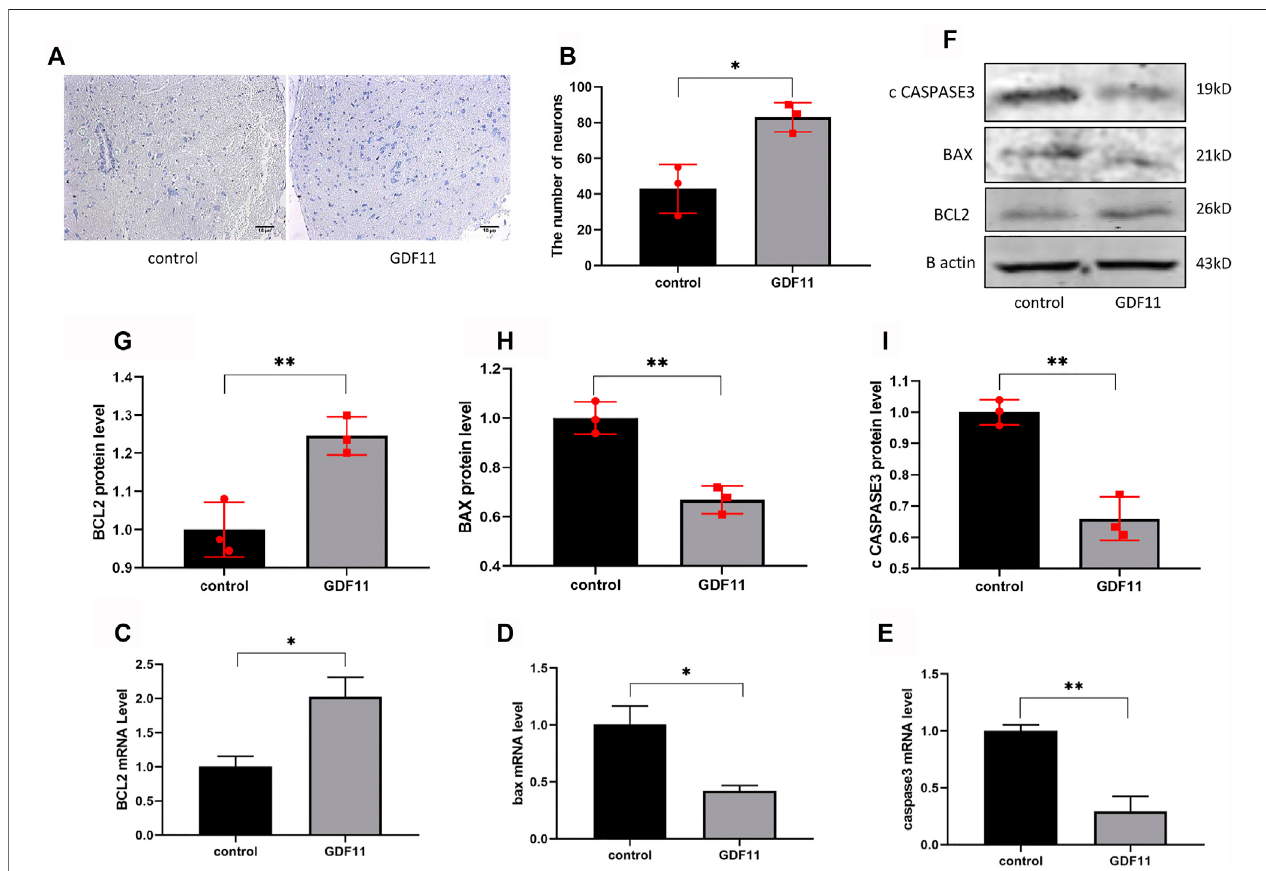
FIGURE7 | GDF11 has aprotective effect on neuronal cells inrats. (Aand B). Three months after surgery, spinal cords ofthe rats were sected for Nissl stainingto assess the number of neurons alive ( n (cid:1) 3). (C, D and E). Three months after surgery, the spinal cord of the rats was extracted for RNA, and the mRNA levels of apoptosis-related genes were detected by RT-PCR( n (cid:1) 3). (F, G, H and I). Three months after surgery, the spinal cord of the rats was extracted for proteins, and then Westernblot wasused tomeasure the protein levels of apoptosis-related genes ( n (cid:1) 3). Statistical analysiswas based on at least three different biological samples and three technical replicates, p < 0.05 was considered to be statistically signiand fi lig;cant. Representative images are